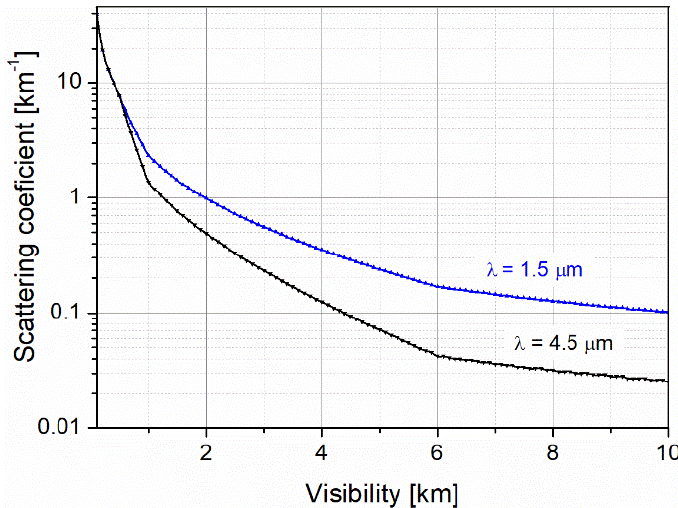
Figure 3. Scattering of light as a function of different visibilities for wavelengths 1.5 and 4.5 µm. Commercially available FSO systems use a radiation of 1.5 µ m wavelength; however, longer wavelengths are preferable in the case of light scattering. The mentioned descrip- tions of scattering are only some approximations of engineering calculations. For example, calculations of fog attenuation are more complex and distinguish the type of impact, i.e., radiation or advection. For advection fog, wavelength dependence of attenuation is linear. The quadratic spectral coefficient is a characteristic of radiation fog and higher light losses are observed. Additionally, the formation of fog is often accompanied by an increase in humidity [20]. The HITRAN database analysis shows that for a wavelength of 4.5 µ m, the air transmission at a distance of 1 km is at least 22% lower as compared with a